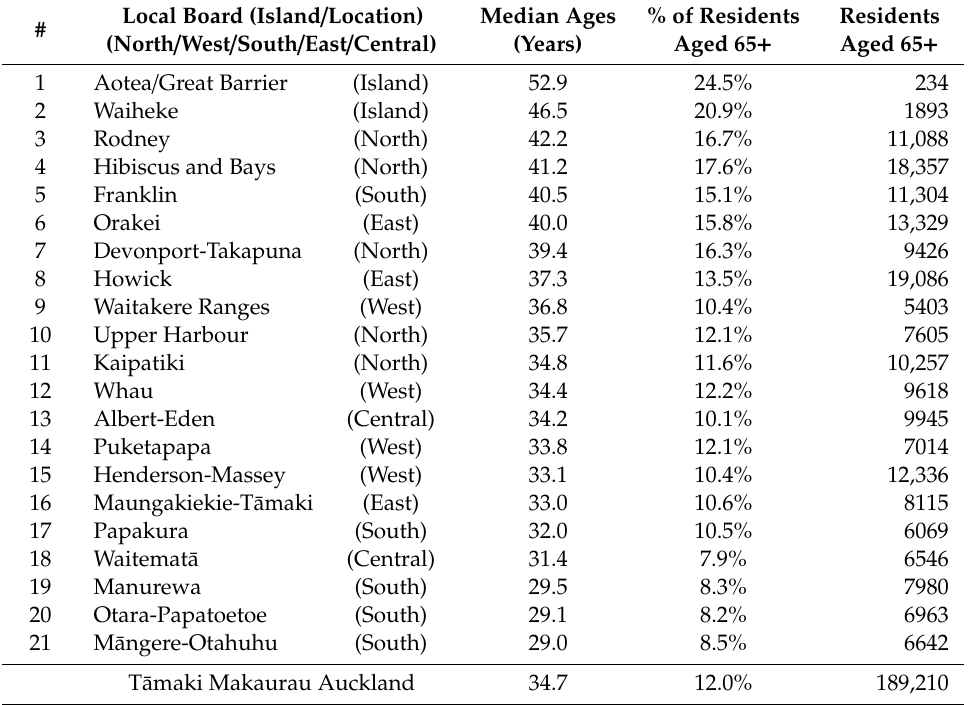
Table 2. T¯amaki Makaurau Auckland’s 21 local boards ranked from oldest to youngest by median age, alongside the percentage and the actual numbers of residents aged 65 + years 1